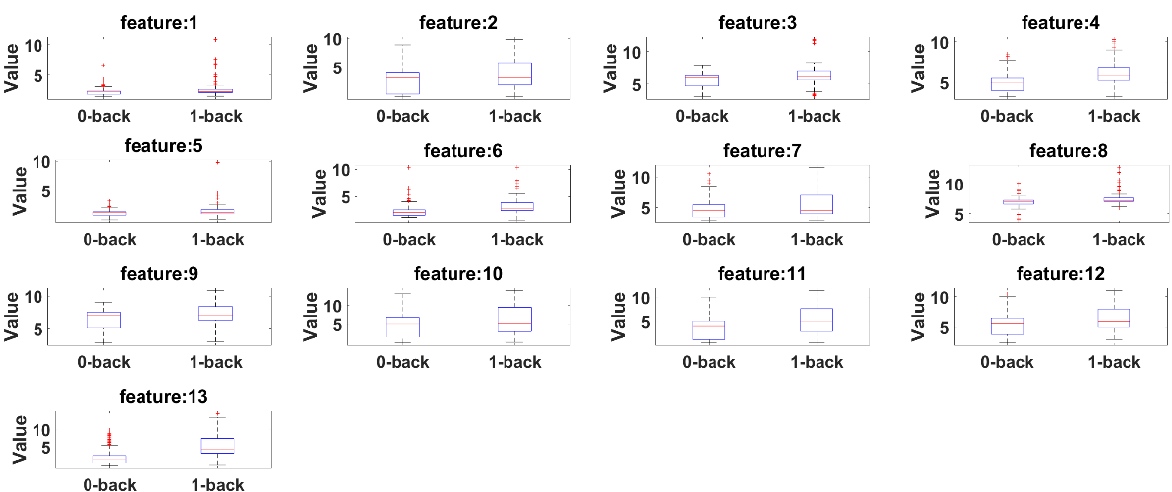
Figure 16. Boxplot of 0-back and 1-back for camera features.